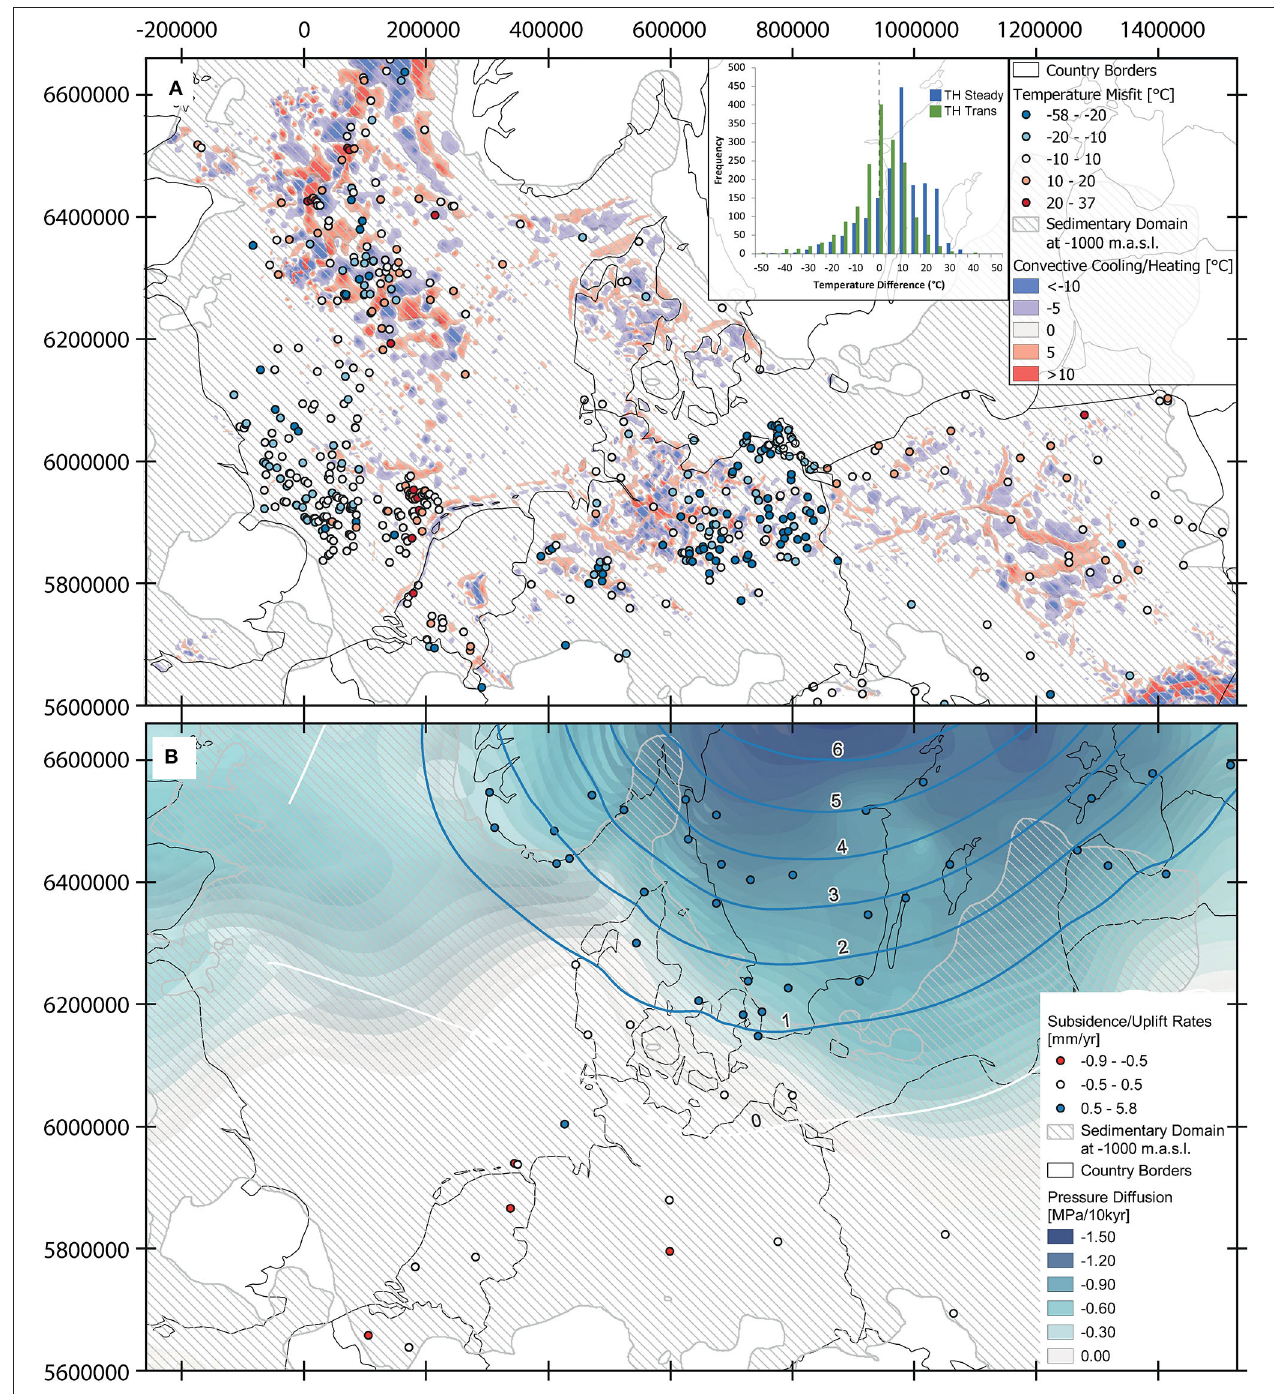
FIGURE 8 | Comparison of modeled data to measured data. (A) Temperature misfit (modeled - measured) between the transient model at present day and available measurements ( Supplementary Material ), blue spheres: model colder than measurements, red spheres: model warmer than measurements. Not all temperature misfits are shown as some localities have more than one measurement vertically. All misfits have been included in the histograms. Backdrop represents influence of convection at − 26 kyrs (TH model – T model), inlay: histogram of temperature misfits for the transient model and the steady state model for 0 kyrs (modeled - measured). (B) Circles represent uplift rates at present day after (Vestøl et al., 2019), contour lines represent the empirical model of uplift rates at present day after (Vestøl et al., 2019), backdrop represents the pore pressure dissipation (depth integrated along the model) at present day plotted along in map view to, illustrate its variations in space (A,B) black lines represent the coastline as derived from the 0m contour of the topography distribution of the top slice of the model, Coordinates are in UTM Zone 32N.